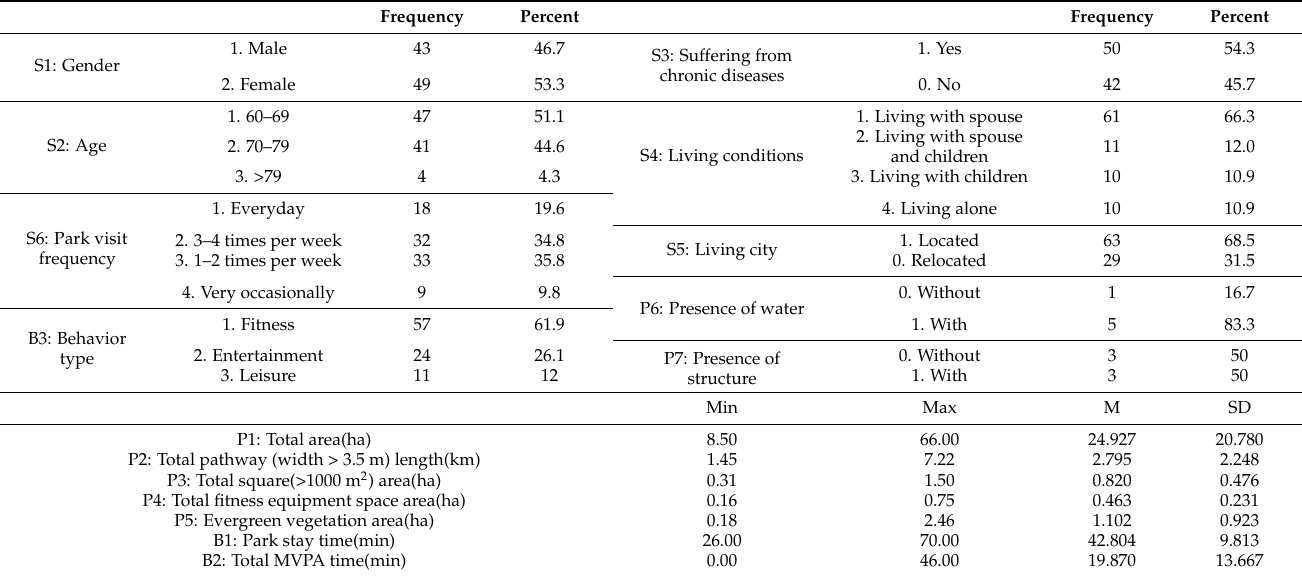
Table 3. Descriptive statistics for senior participants, parks and behavioral